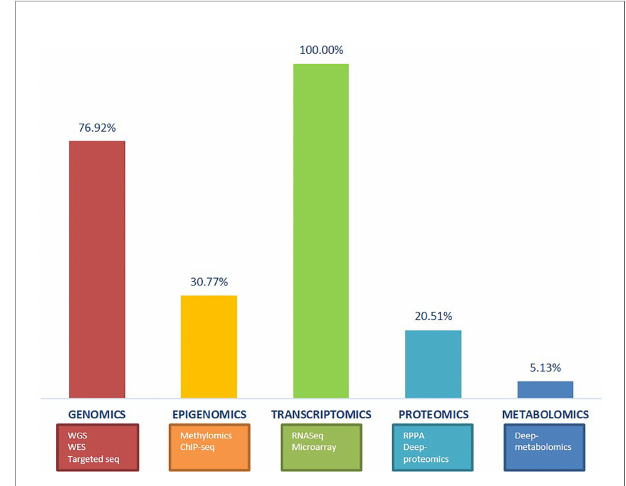
FIGURE 1 | The frequency of use for each omics technologies in the multi- omics studies mentioned in this review. The frames below list the common methods of each